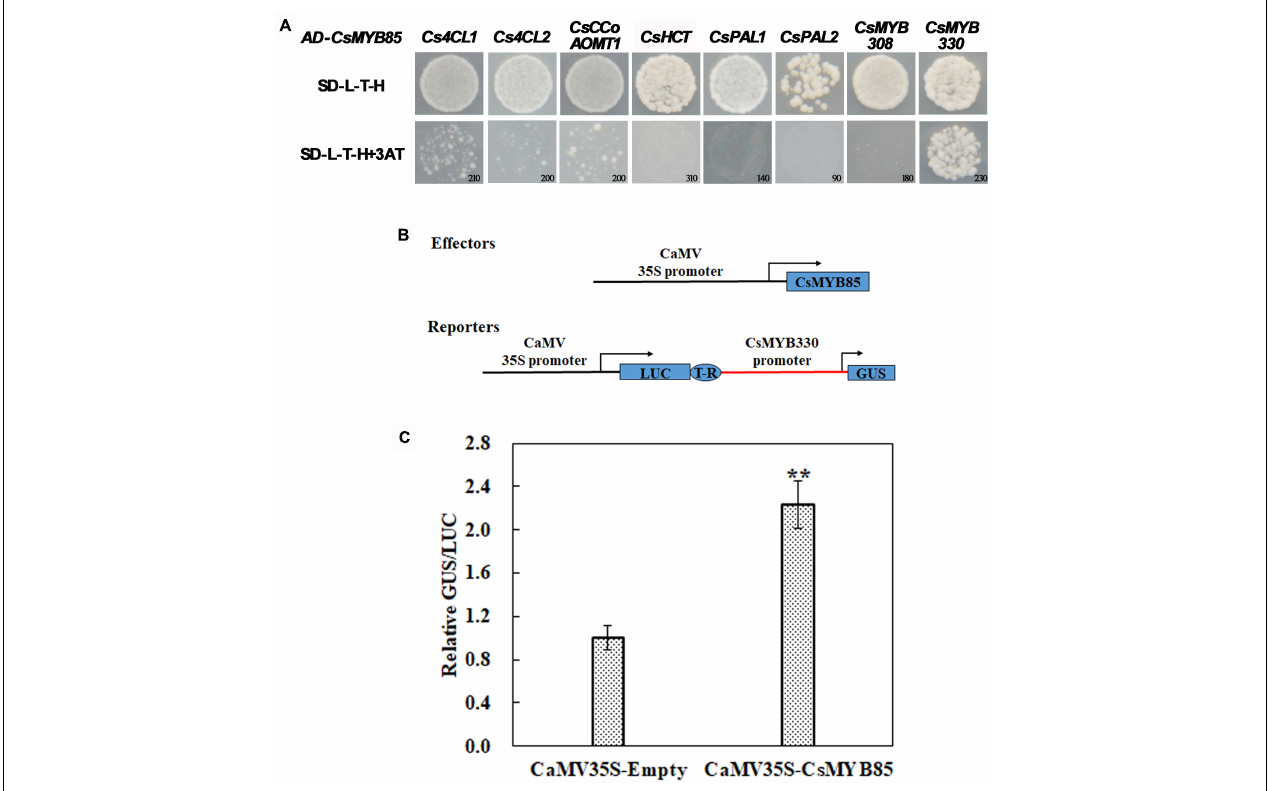
FIGURE 4 | Interactions between CsMYB85 and the promoters of lignin biosynthesis-related genes. (A) Interactions of CsMYB85 with the promoters of CsMYB330, CsMYB308 , Cs4CL1 , Cs4CL2 , Cs4CCoAOMT1 , CsHCT , CsPAL1, and CsPAL2 were identified using Y1H assays. The promoters were inserted into pHIS2 vectors. Empty AD and constructed pHIS2 vectors were transfected into yeast Y187 cells, which were grown on SD/–L/–T/–H dropout medium containing various concentrations of 3-amino-1,2,4-triazole (3-AT) to suppress background histidine leakiness. Numbers in the lower-right corner of the images indicate the optimal 3-AT concentrations. Results were obtained from three independent transformation experiments. (B) Activation of the CsMYB330 promoter by CsMYB85 was assayed transiently in Nicotiana benthamiana leaves using an effector and reporter system. The effector and reporter constructs are shown in the schematic diagram. The reporter vector contained LUC normalization and GUS reporter genes driven by the CaMV35S and CsMYB330 promoters, respectively. The effector vector contained a CsMYB85 gene under control of the CaMV35S promoter. T-R, terminator; Boxes, various DNA sequences. (C) Transcriptional activity of CsMYB85 was analyzed using a GUS reporter gene driven by the CsMYB330 promoter. The GUS/LUC ratio in leaves transformed with the empty vector (control) harboring the CsMYB330 promoter was set to 1. Error bars represent standard errors. Means were obtained from five biological replicates. Student’s t -test: ∗∗ P < 0.01.